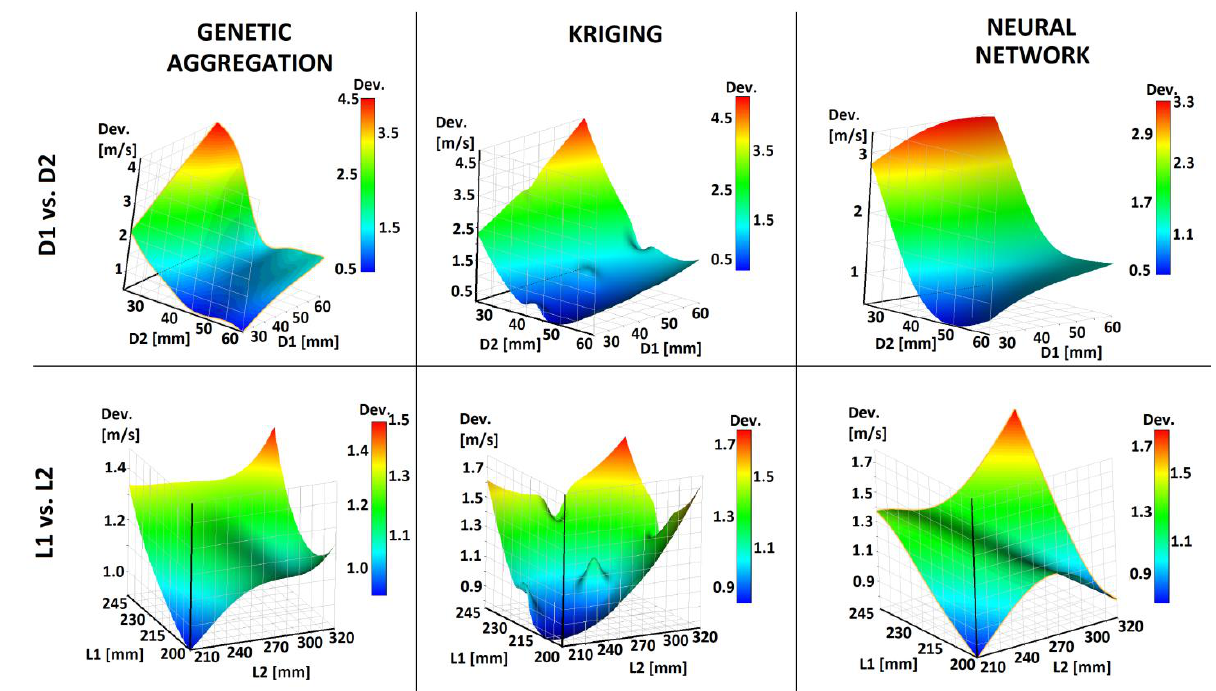
Fig. 7. Response surfaces created for pairs of the input parameters using selected